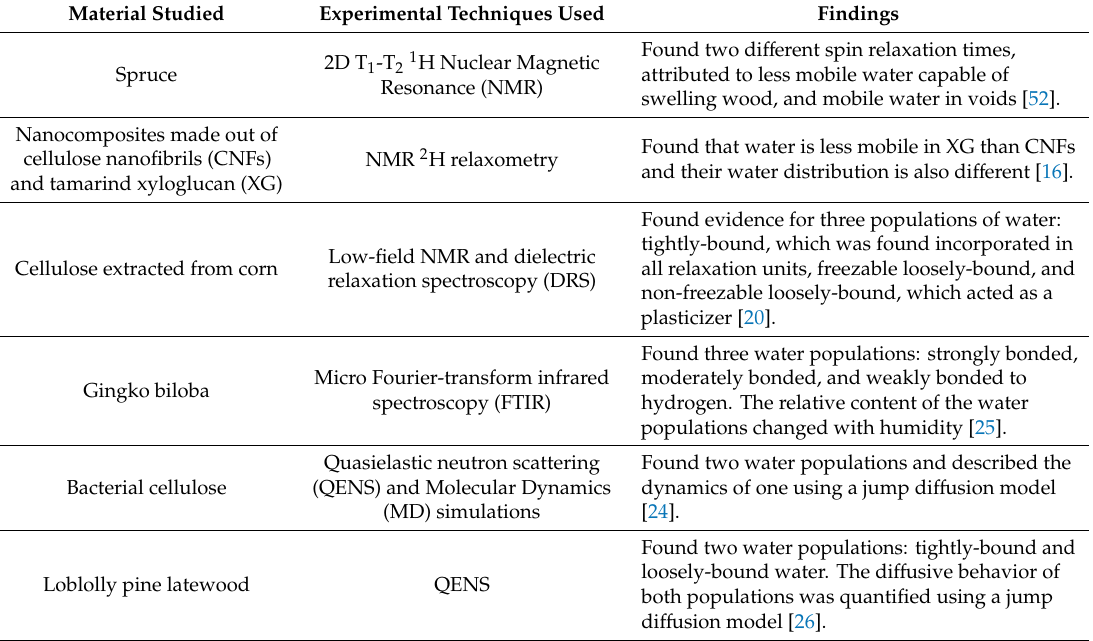
Table 2. Summary of studies focused on the state of water absorbed in wood and its